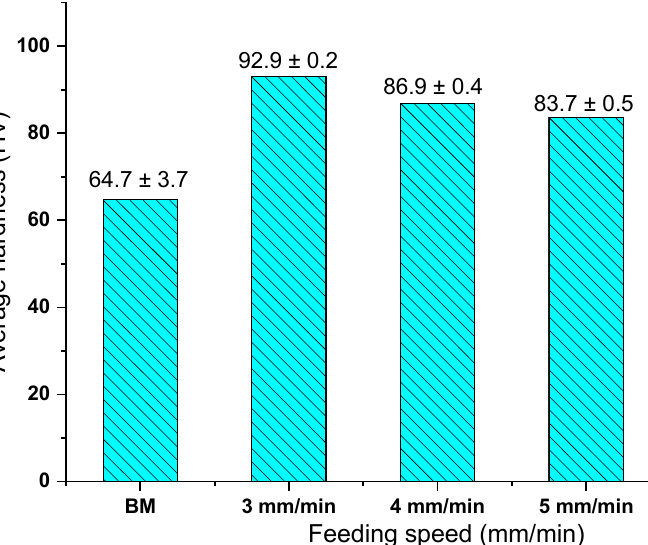
Figure 15 . The average hardness values of as-cast A356 and AMPs deposited at a 1200 rpm rotation speed and feeding rates of 3, 4, and 5 mm/min.